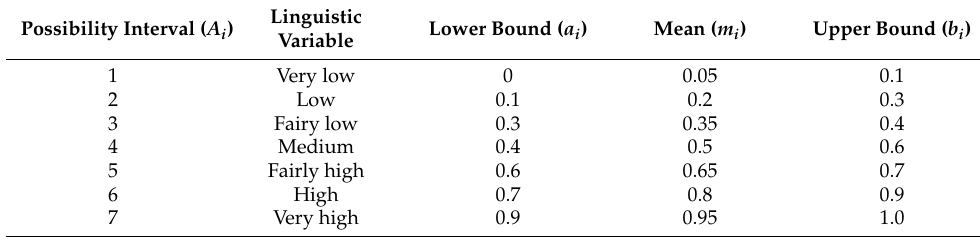
Table 2. Division of possibility intervals.